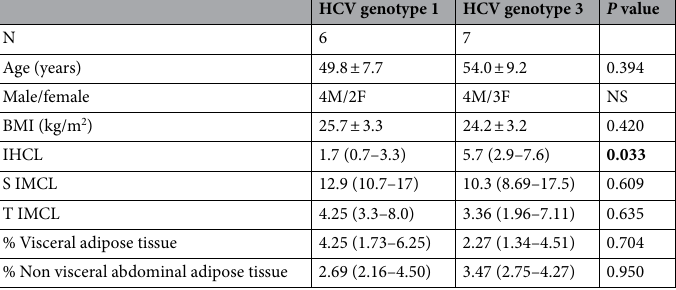
Table 3. Subgroup with whole body MRI fat quantification. BMI body mass index, IHCL intrahepatocellular lipid, S IMCL intramyocellular lipid, T IMCL tibias intramyocellular lipid. Significant values are in bold.